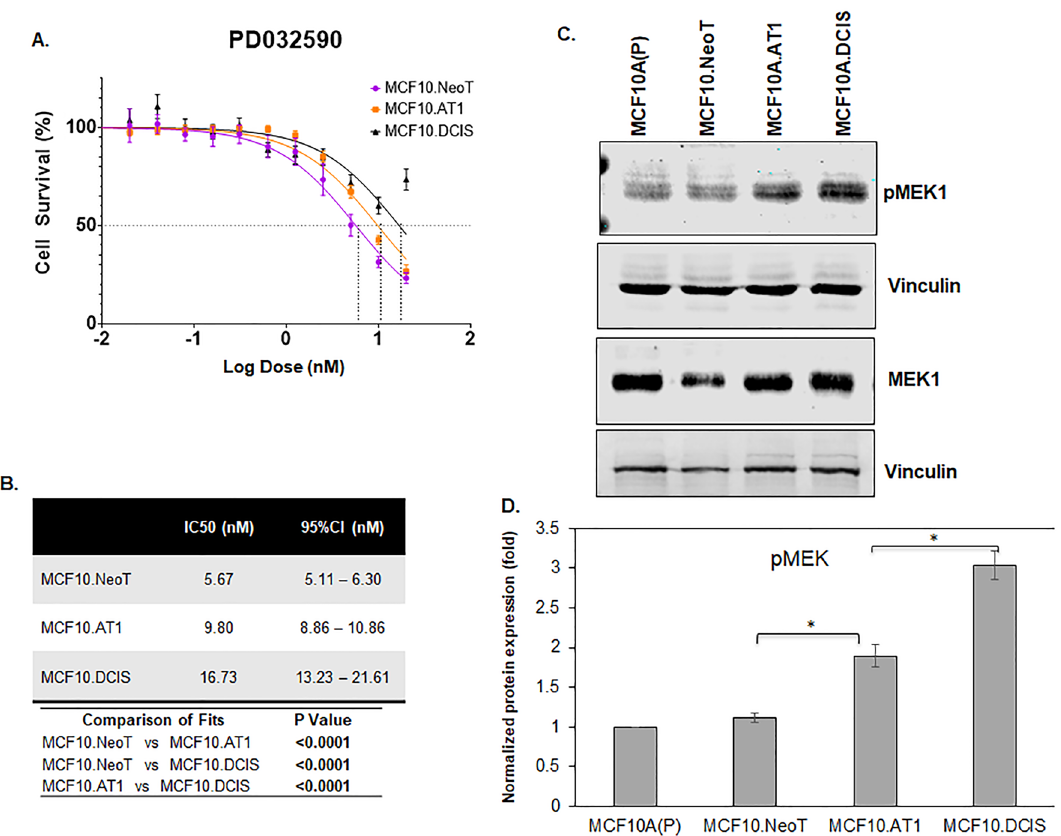
Figure 3. Aberrant activation of the pMEK pathway at baseline is associated with lower efficacy of a MEK inhibitor. ( A ) Cell survival curves as measured by MTT assay show inhibition in proliferation of MCF10.NeoT, MCF10.AT1 and MCF10.DCIS cells by MEK inhibitor PD0325901. ( B ) Table shows the IC50 and p values for each cell line. ( C ) Western blot and ( D ) its quantification shows upregulation of pMEK in the MCF10A breast cancer progression panel. pMEK expression was normalized to vinculin and total MEK levels. The same vinculin or β-actin bands may be shown for multiple proteins (and figures) if they came from the same membrane.Bar diagram: average values ± standard error of the mean (SEM). *p <